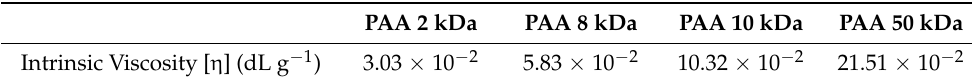
Table 3. Mark–Houwink calibration with